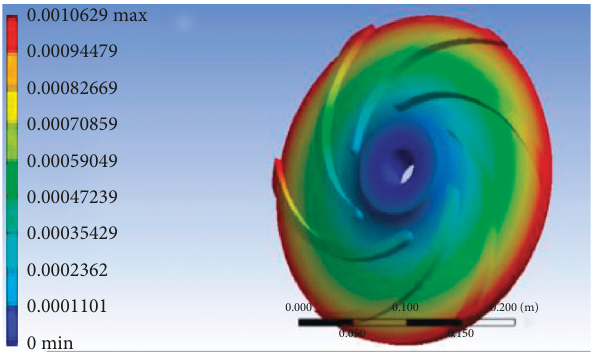
Figure 18: Stress distribution before optimization.